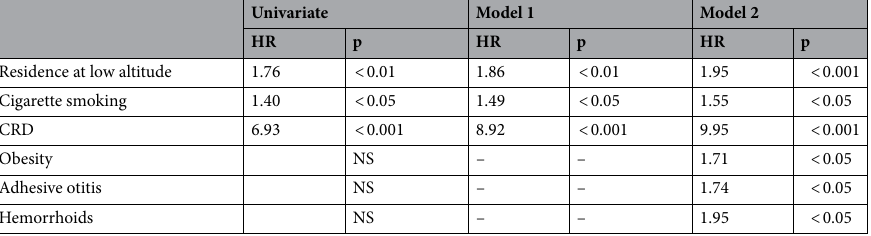
Table 3. Cox proportional hazards for selected predictors of non-survival at high-altitude work in crude and adjusted analyses. CRD chronic rheumatic disease, HR hazard ratio, Model 1 adjusted for each other (residence; smoking and CRD) , Model 2 adjusted for variables in Model 1 and all diagnoses (N =